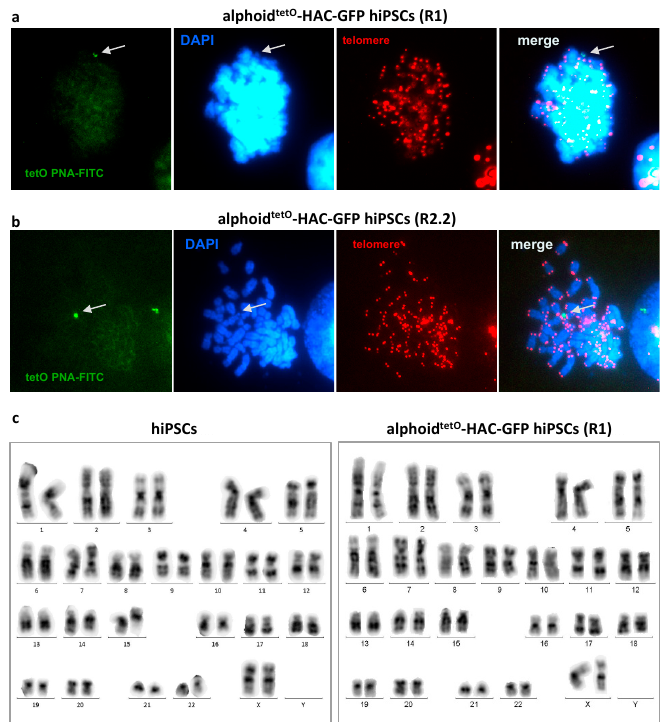
Cells 2018 , 7 , x FOR PEER REVIEW 10 of 14 of GFP expression in some cells, or both. To address this, we separated the GFP-positive and GFP- negative cells by FACS and followed GFP expression in these sub-populations. Importantly, both sub-populations behaved similarly in standard culture conditions. However, even after one passage, GFP-negative cells emerged in population enriched for GFP-positive cells (Figure S3). On the other side, GFP-positive cells also emerged in GFP-negative population (Figure S3), suggesting that the former cells contain the HAC with silenced GFP whose expression is re-initiated after 1–2 passages.